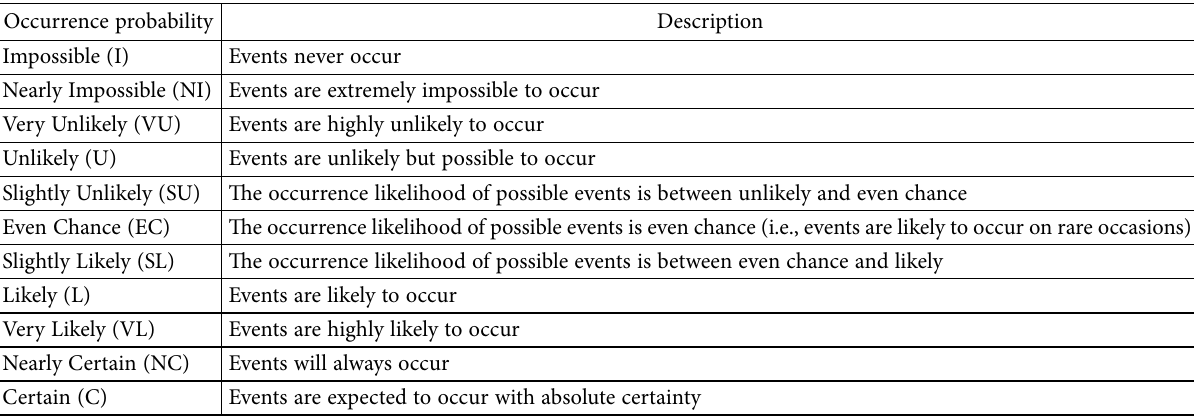
Table B1. The 11-point linguistic scale for assessing occurrence probability of each risk